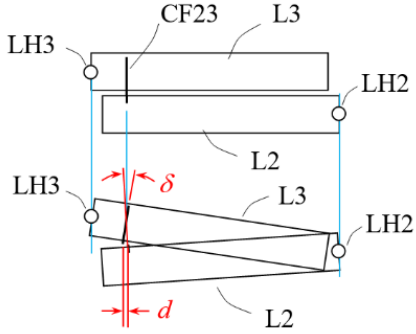
Figure 5. Exaggerated depiction of relative translational displacement d and rotational displacement δ between two adjacent levers at the location of the coupler, in the conceptual design B.